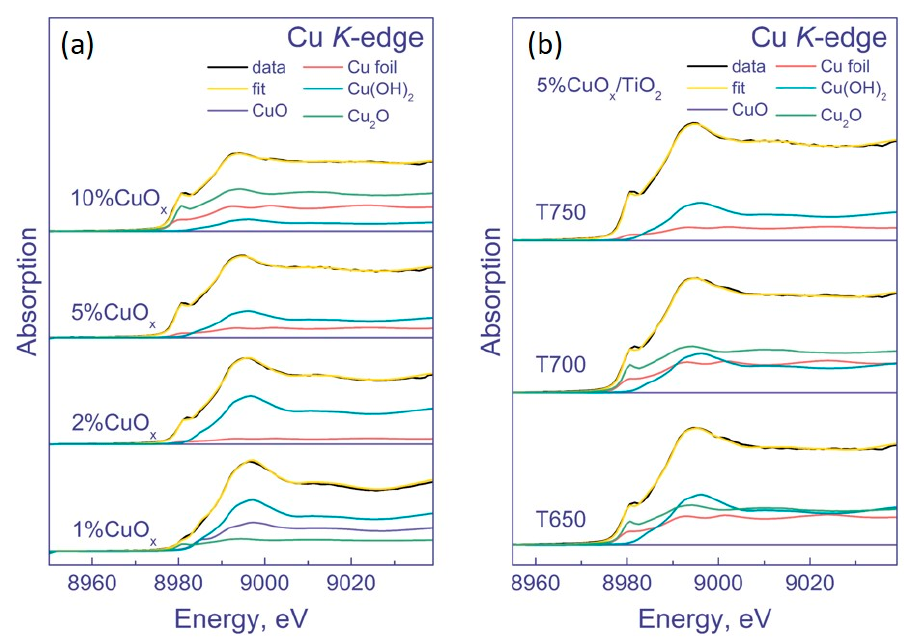
Figure 6. XANES spectra of the K-edge of Cu and their decomposition into a linear set of spectra of metallic copper, CuO, Cu 2 O, and Cu(OH) 2 ( a ) (1–10)% CuO x /DTiO 2 T750; ( b ) 5% CuO x /DTiO 2 T650–T750.